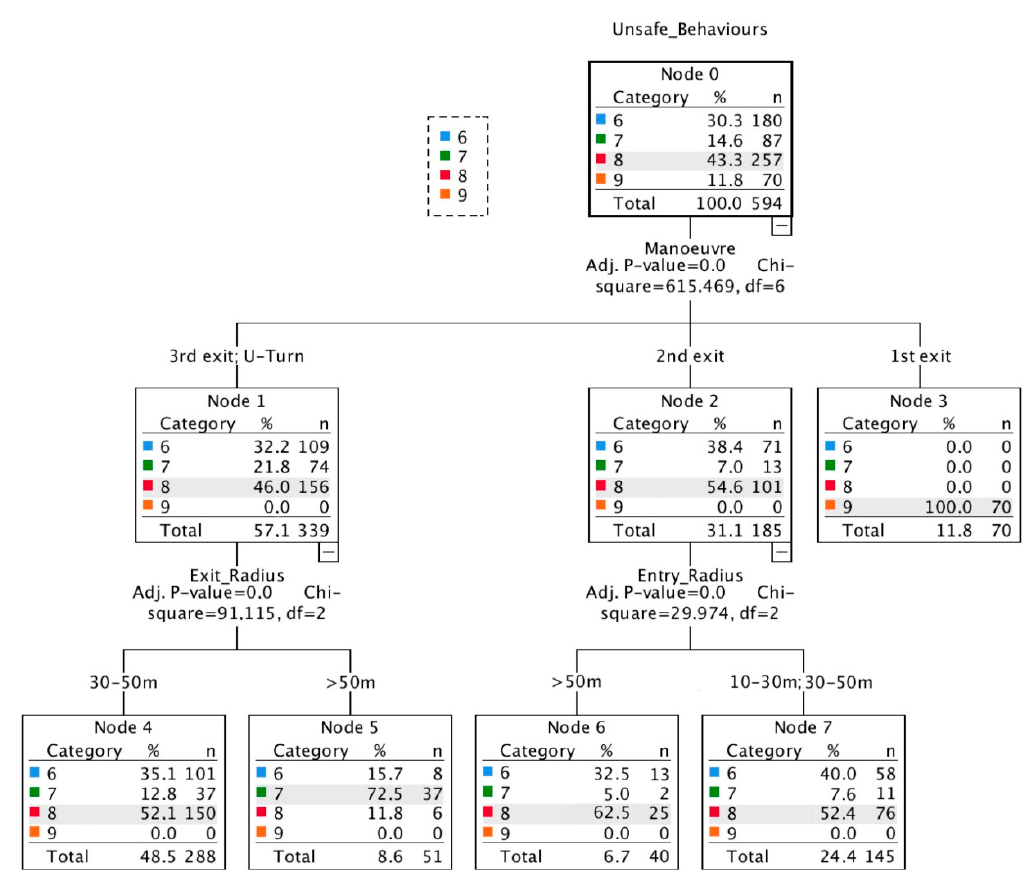
Figure 4. Tree diagram obtained from CHAID analysis for circulation unsafe behaviors at double-lane roundabouts.